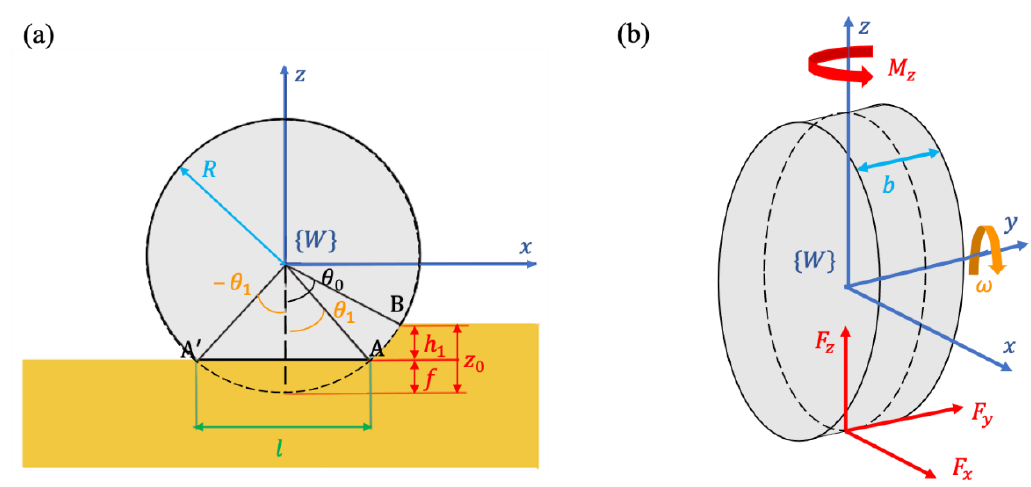
Figure 1. ( a ) Contact between compliant wheel and compliant terrain and ( b ) interaction forces acting on the rover’s